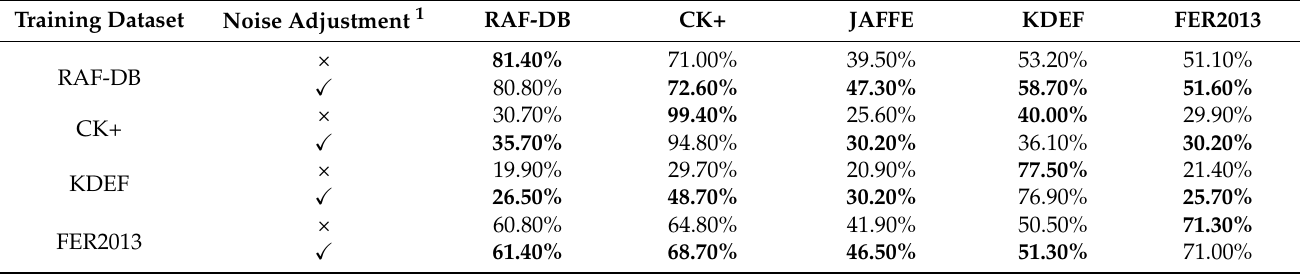
Table 3. Model recognition performance before and after noise adjustment in the training